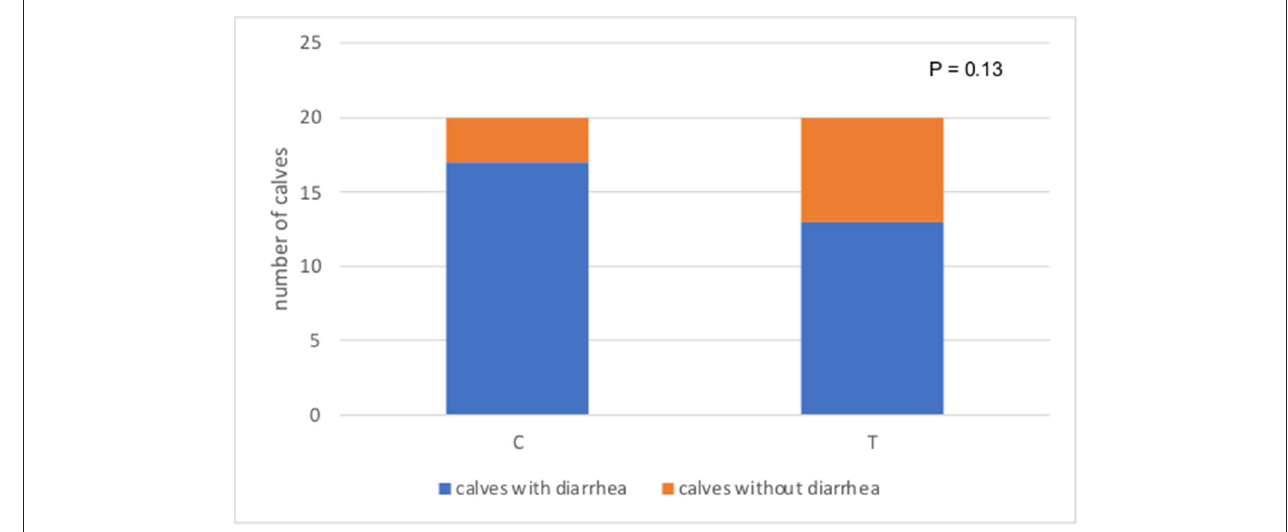
FIGURE 1 | Number of calves with diarrhea in the control (C) and treatment group